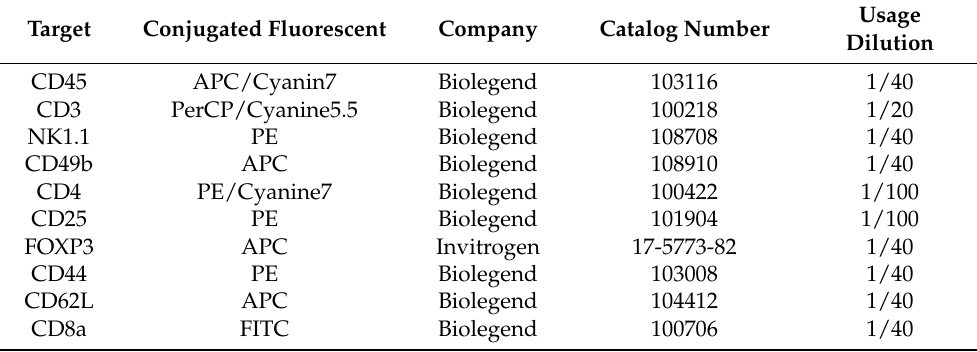
Table 1. The dilutions and catalog numbers of the antibodies of flow cytometry.